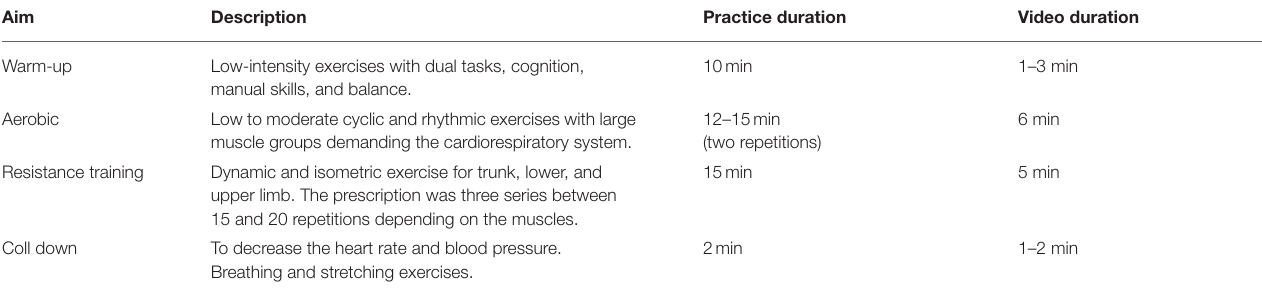
TABLE 1 | Description of the content of the video sessions.